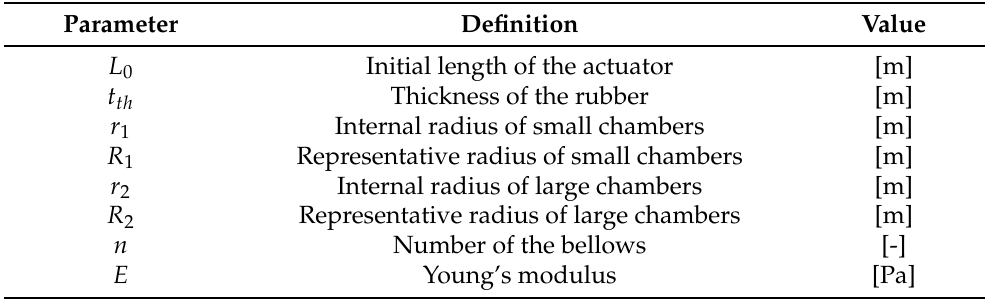
Table 1. Parameters of the actuator’s characteristics.